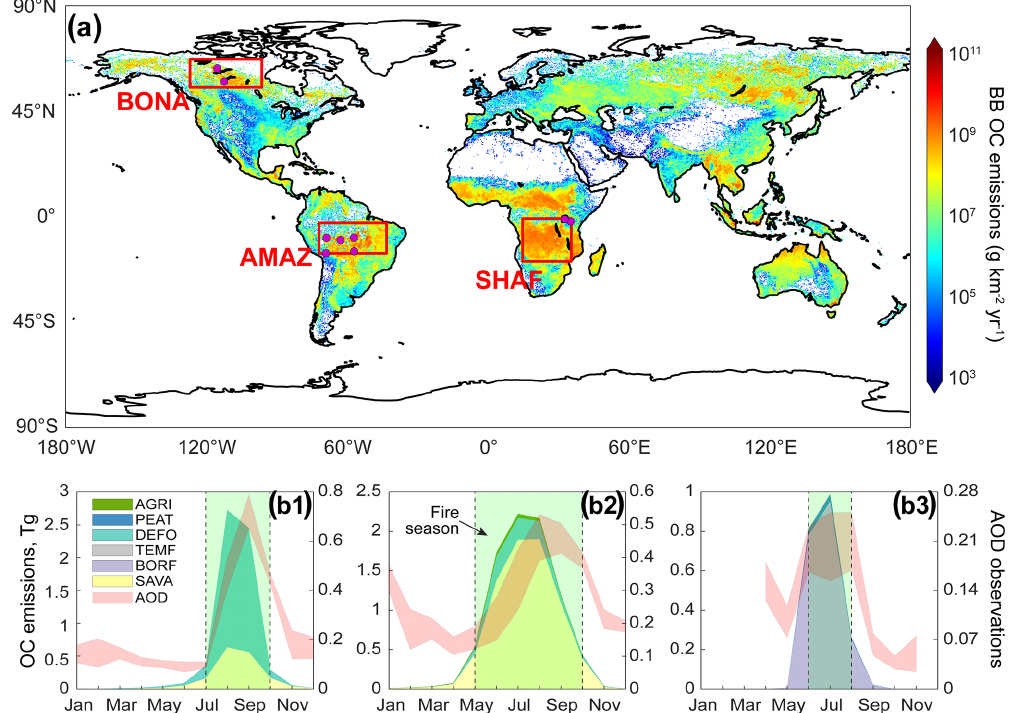
Figure 1. Three focused fire regions in this study. (a) Global map of BB OC emissions averaged for 2006, 2008, and 2010 based on GFED4.1s (https://www.globalfiredata.org/, last access: October 2021). The domains of the three fire regions are shown by the red boxes together with the AERONET sites (purple dots). (b) The monthly evolutions of BB OC emissions from six fire types in AMAZ (b1) , SHAF (b2) , and BONA (b3) , respectively. The un-collocated regional mean AOD observations from 14 satellite datasets are shown by the light-red-shaded areas as interquartile ranges (only the grid boxes with more than 20 data available in a month are included). Emissions for BB were considered in terms of the biome/fire type: tropical forest and deforestation (DEFO), savanna (SAVA), temperate forest (TEMF), boreal forest (BORF), peat (PEAT), and agricultural waste